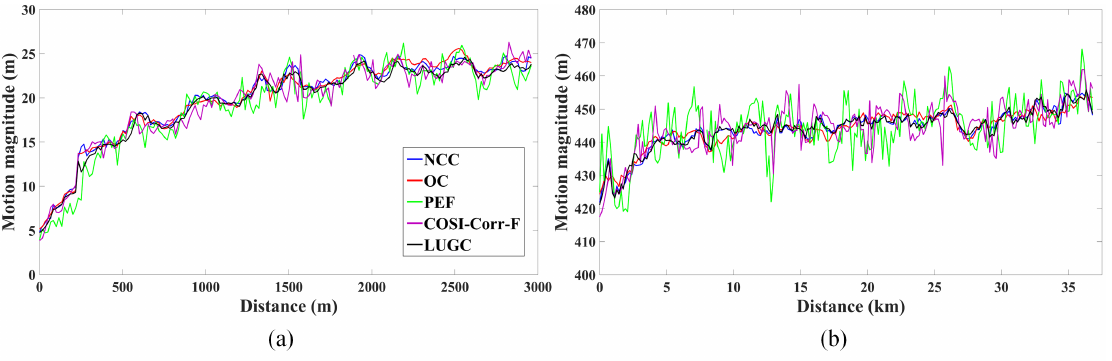
Figure 9. Magnitudes of surface motions along the two marked profiles. ( a ) Profile A; and ( b ) Profile